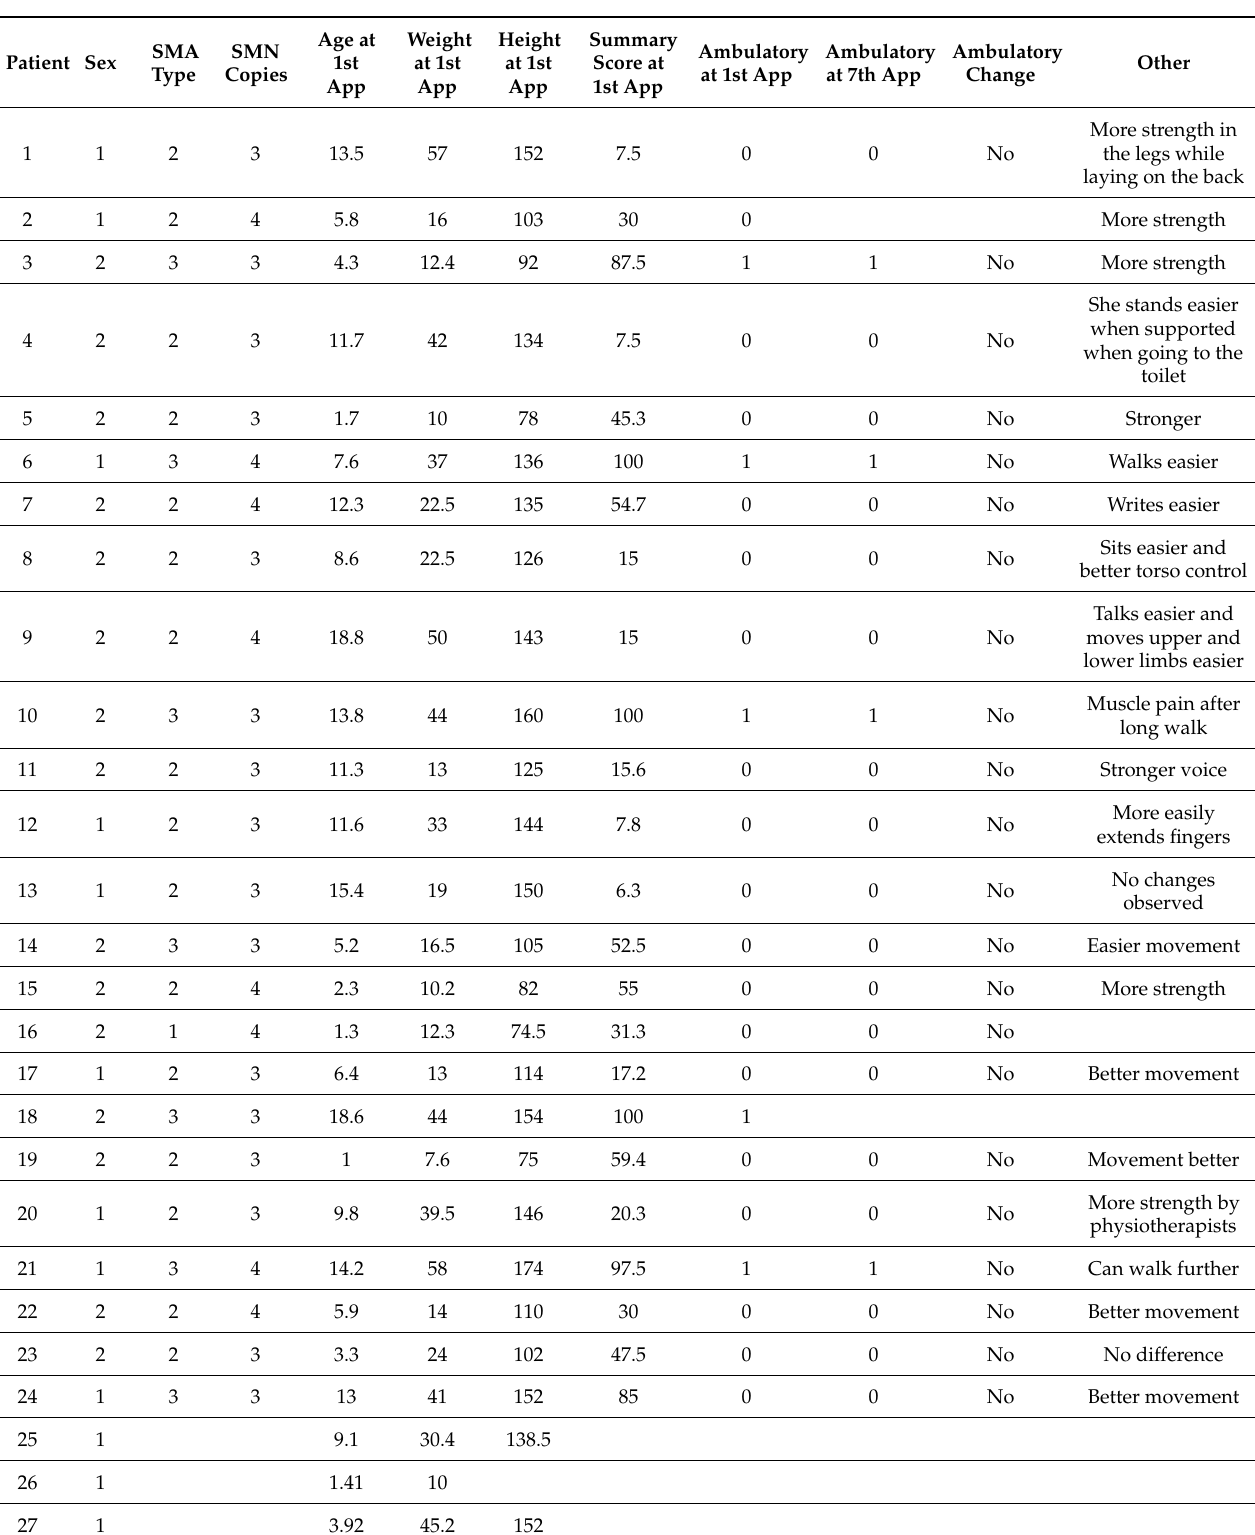
Table 1. Clinical data obtained from spinal muscular atrophy (SMA) patients. Due to the small cohort size, patients’ data were